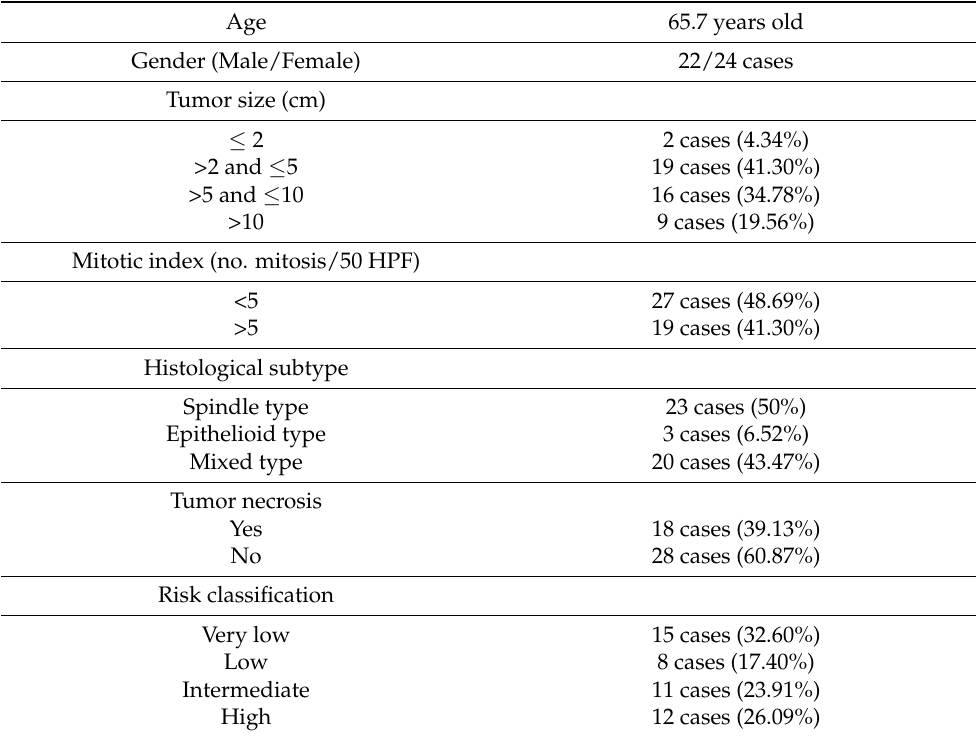
Table 1. Clinicopathological characteristics of gastric Gastrointestinal stromal tumors